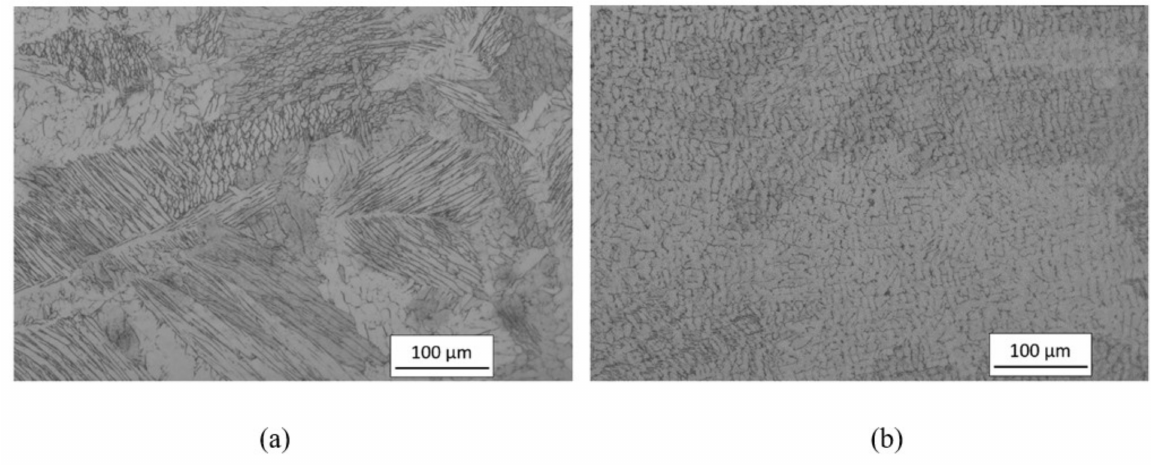
Figure 11. Microstructure within the fusion zone when the welds were made using ( a ) pure Ar and ( b ) 10% N 2 + Ar as the shielding